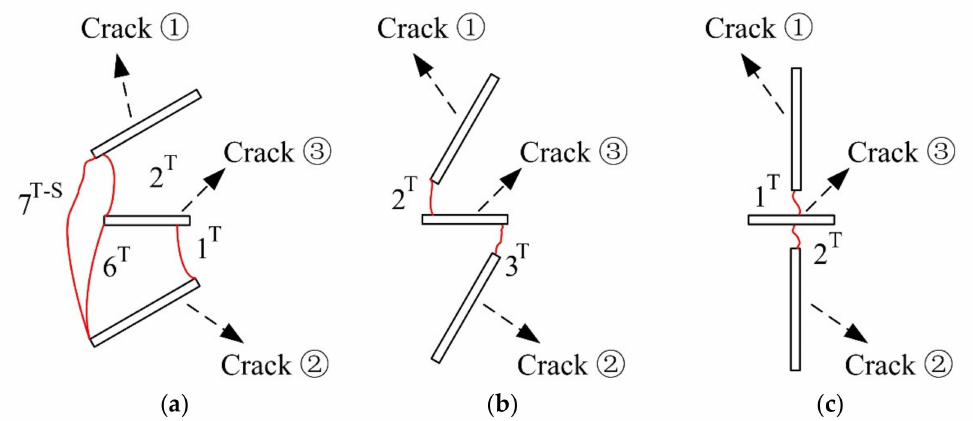
Figure 10. Schematic diagram of crack coalescence on the limestones’ surface with different parallel cracks: ( a ) P − 30 − 1; ( b ) P − 60 − 2; ( c ) P − 90 −